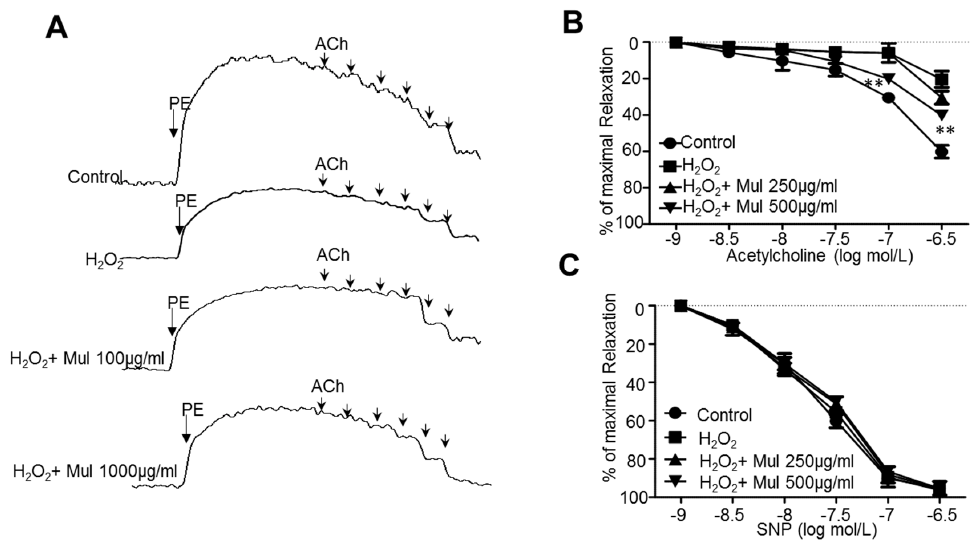
Figure 6. Mulberry prevents endothelial dysfunction in aortic arteries isolated from rats ex vivo. Aortas were exposed to 0.2 mmol/L H 2 O 2 for 2 h in which water or mulberry (250 or 500 µg/mL) was treated during the subsequent 30 min in aortas. ( A–B ) The endothelium-dependent relaxation induced by acetylcholine (ACh) was analyzed and ( C ) endothelium-independent relaxation was also confirmed by sodium nitroprusside (SNP) in an organ chamber. All data are expressed as mean ± SEM. ( n = 5; ** p <0.05 versus H 2 O 2 ).